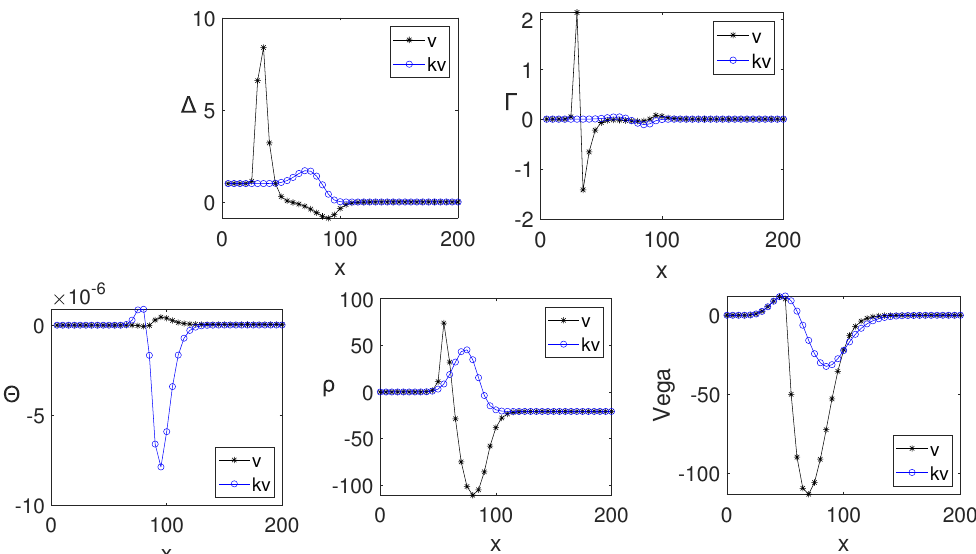
Figure 15. H x = H y = H z = 0.7, figures represent in turn are Delta, Gamma, Theta, Rho and Vega. The blue curve stands for option price with knock-in-barrier while the black curve represents option price without knock-in-barrier. For interpretation of the references to color in the figure, the reader is referred to the web version of the